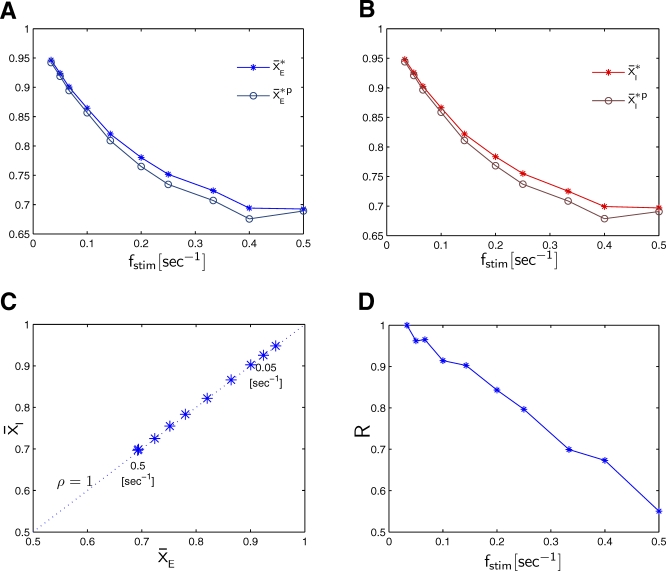
Frequency-Dependent Adaptation in Simulated NetworksA total of 10 different networks were stimulated repeatedly at various frequencies (1/30 s−1, 1/20 s−1, 1/15 s−1, 1/10 s−1, 1/7 s−1, 1/5 s−1, 1/4 s−1, 1/3 s−1, 1/2 s−1), and the results were averaged.(A, B) Steady-state values of the state variables
and their predicted values
(see Figure 5) were computed from the last 8 cycles of each simulation.
(C) The phase plane fixed points are indeed located close to the diagonal of ρ = 1 , as expected.(D) The last 8 responses from all the networks were averaged to produce the steady-state responsiveness of the system.